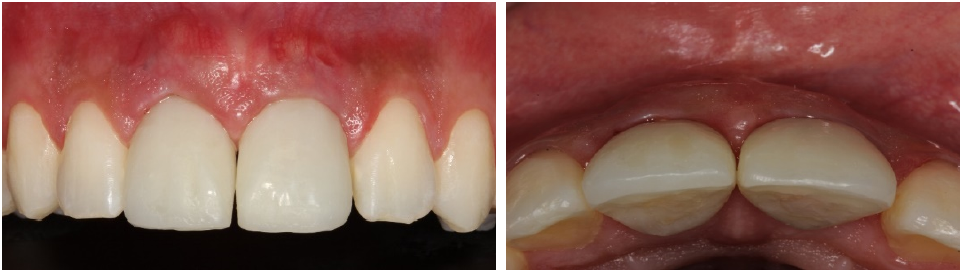
Figure 12. Surgical follow-up after 5 months, showing tissue remodeling and perfect adaptation of the provisional material.